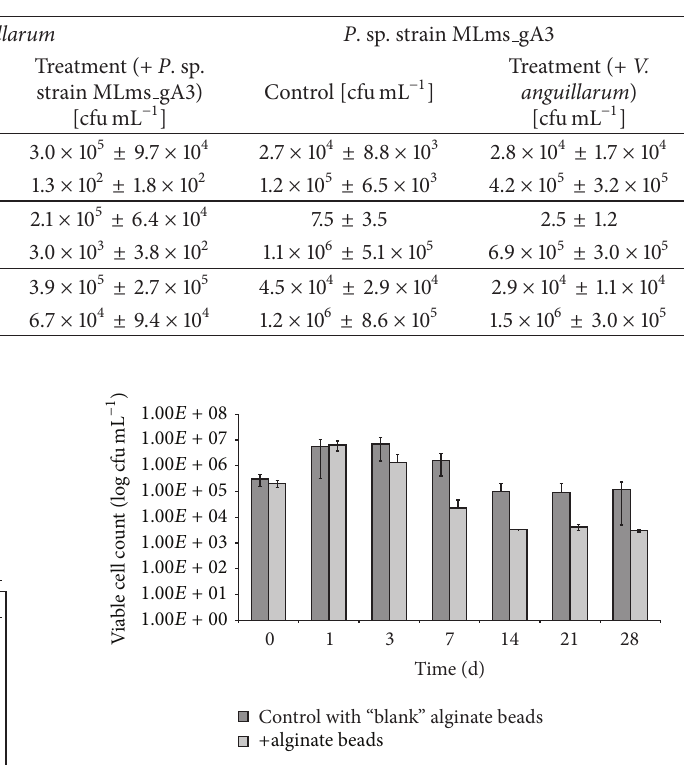
Figure 3: Logarithmic presentation of V. anguillarum viable cell counts [cfumL −1 ] in the presence of P. sp. strain MLms gA3 loaded alginate beads over a period of 28 days (light grey bars). The survival is presented in comparison to a setup with empty alginate beads as the control (dark grey bars). The initial concentration of V. anguillarum was the same in both treatments ( ∼ 10 5 cfu mL −1 ; see also Table 2, 0 d